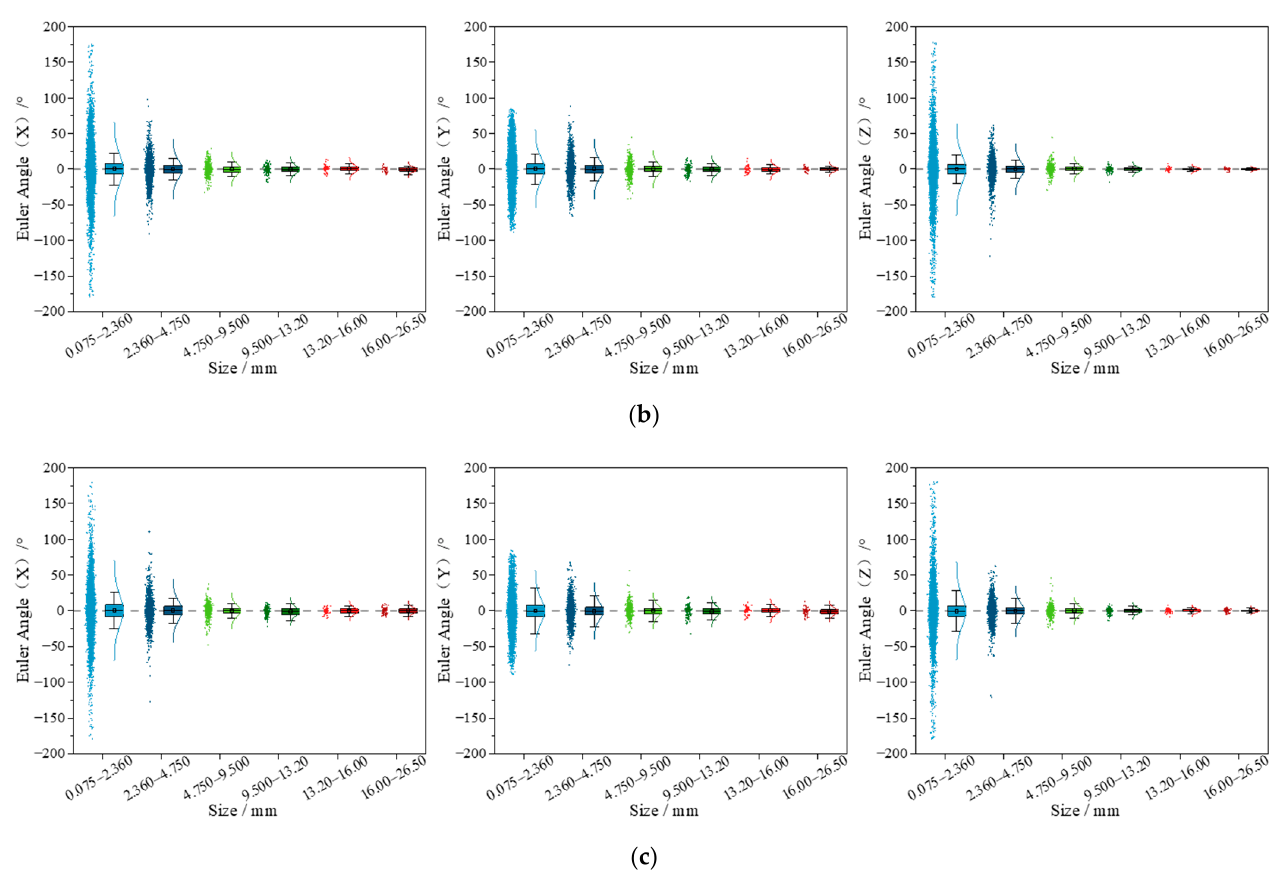
Figure 19. DEM-simulated Euler angles of particles within different size ranges for UPAB specimens with ( a ) G/S = 1.0, ( b ) G/S = 1.8, and ( c ) G/S = 2.5.